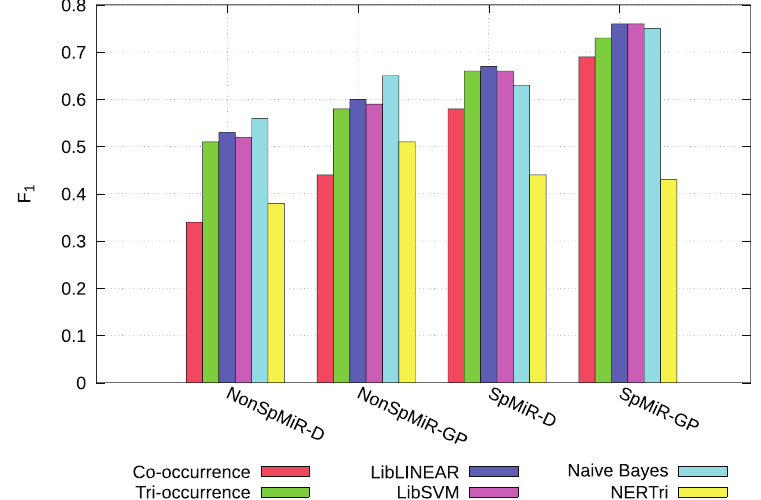
Figure 2. Comparison of different relation extraction approaches. On the x-axis, different entity pair relations are represented as SpMiR-D for S pecific mi RNA-D isease , SpMiR-GP for S pecific mi RNA-G ene /P rotein , NonSpMiR-D for N on -S pecific mi RNA-D isease , and NonSpMiR-GP for N on -S pecific mi RNA-G ene /P rotein